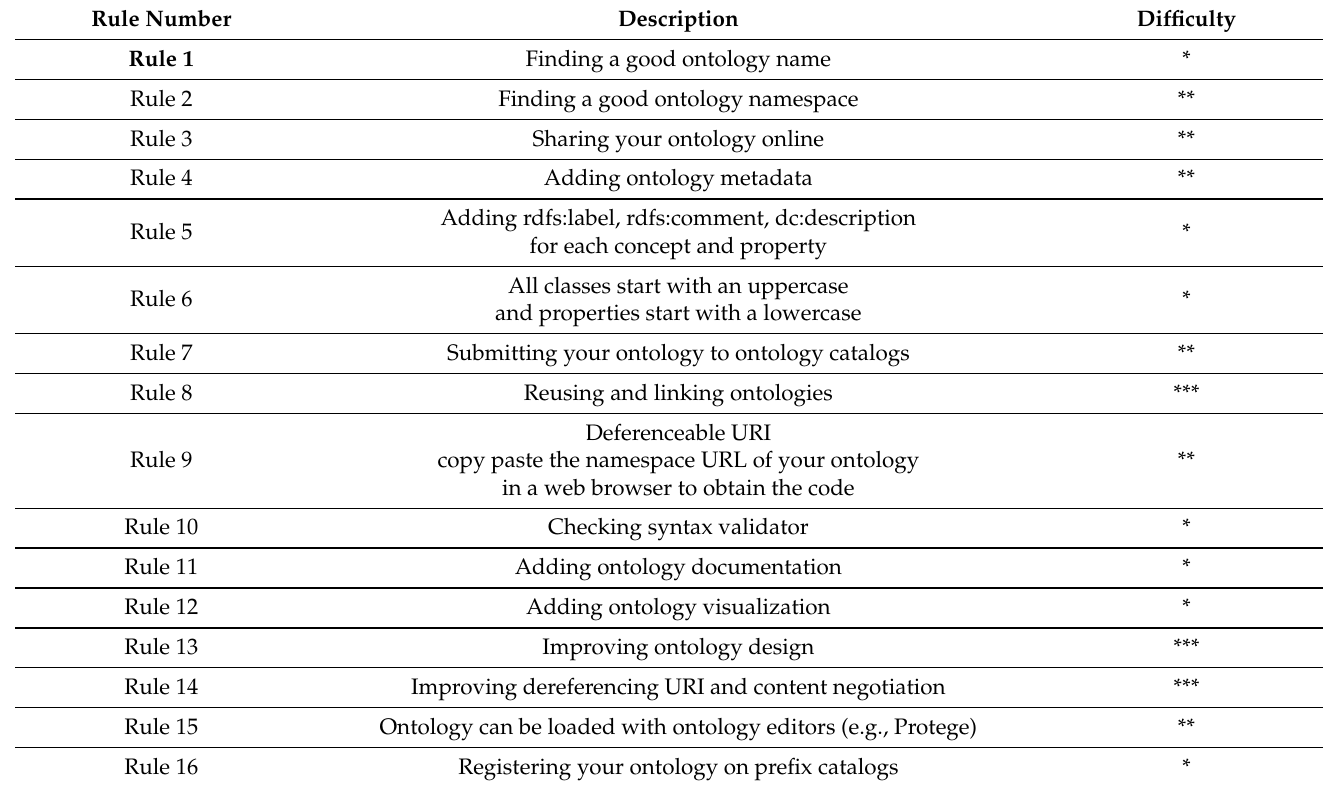
Table 7. Ontology best practices: check list summary [91]. Legend: * means the level of complexity to achieve the rule. ** is secondary complexity. *** is the most complex